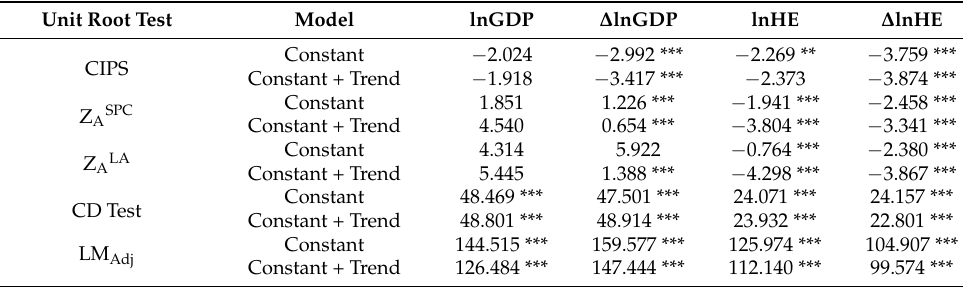
Table 3. Unit Root and Cross-Section Dependency Test Results.